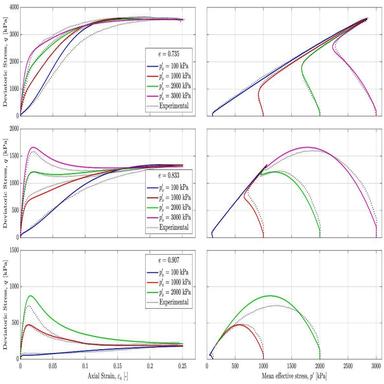
Toyoura sand. Simulations compared with experiments in undrained triaxial tests (adapted from Verdugo & Ishihara).